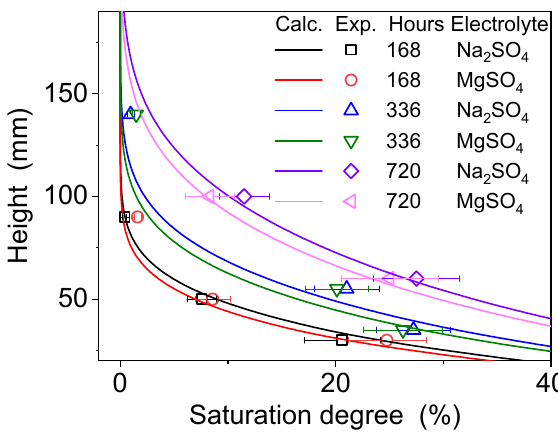
Figure 5. Local saturation degrees of solutes at different diffusion times in the dissolution and diffusion process of bloedite.